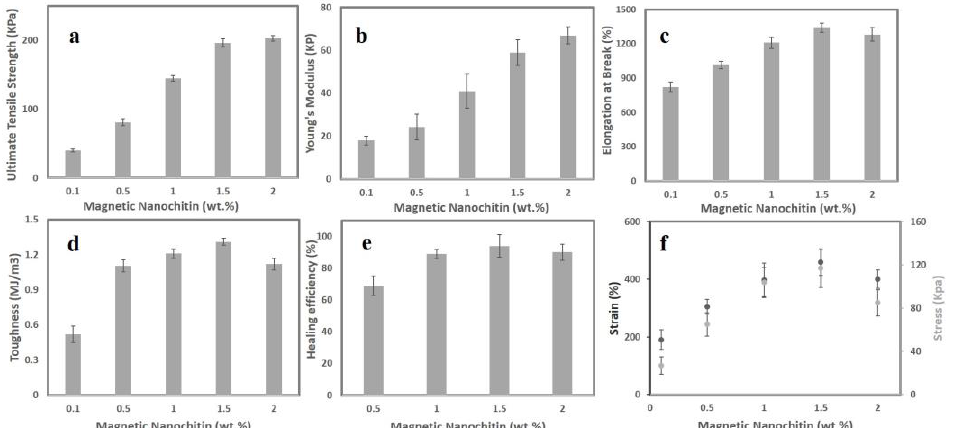
Figure 2. ( a ) Ultimate tensile strength for ferrogels at different magnetic nanochitin concentrations; ( b ) Young’s modulus for ferrogels at different magnetic nanochitin concentrations; ( c ) elongation at break of ferrogels at different magnetic nanochitin concentrations; ( d ) toughness of ferrogels at different magnetic nanochitin concentrations; ( e ) tensile strength healing efficiency of ferrogels at different magnetic nanochitin concentrations; and ( f ) notch sensitivity analysis of ferrogels at varying concentrations.